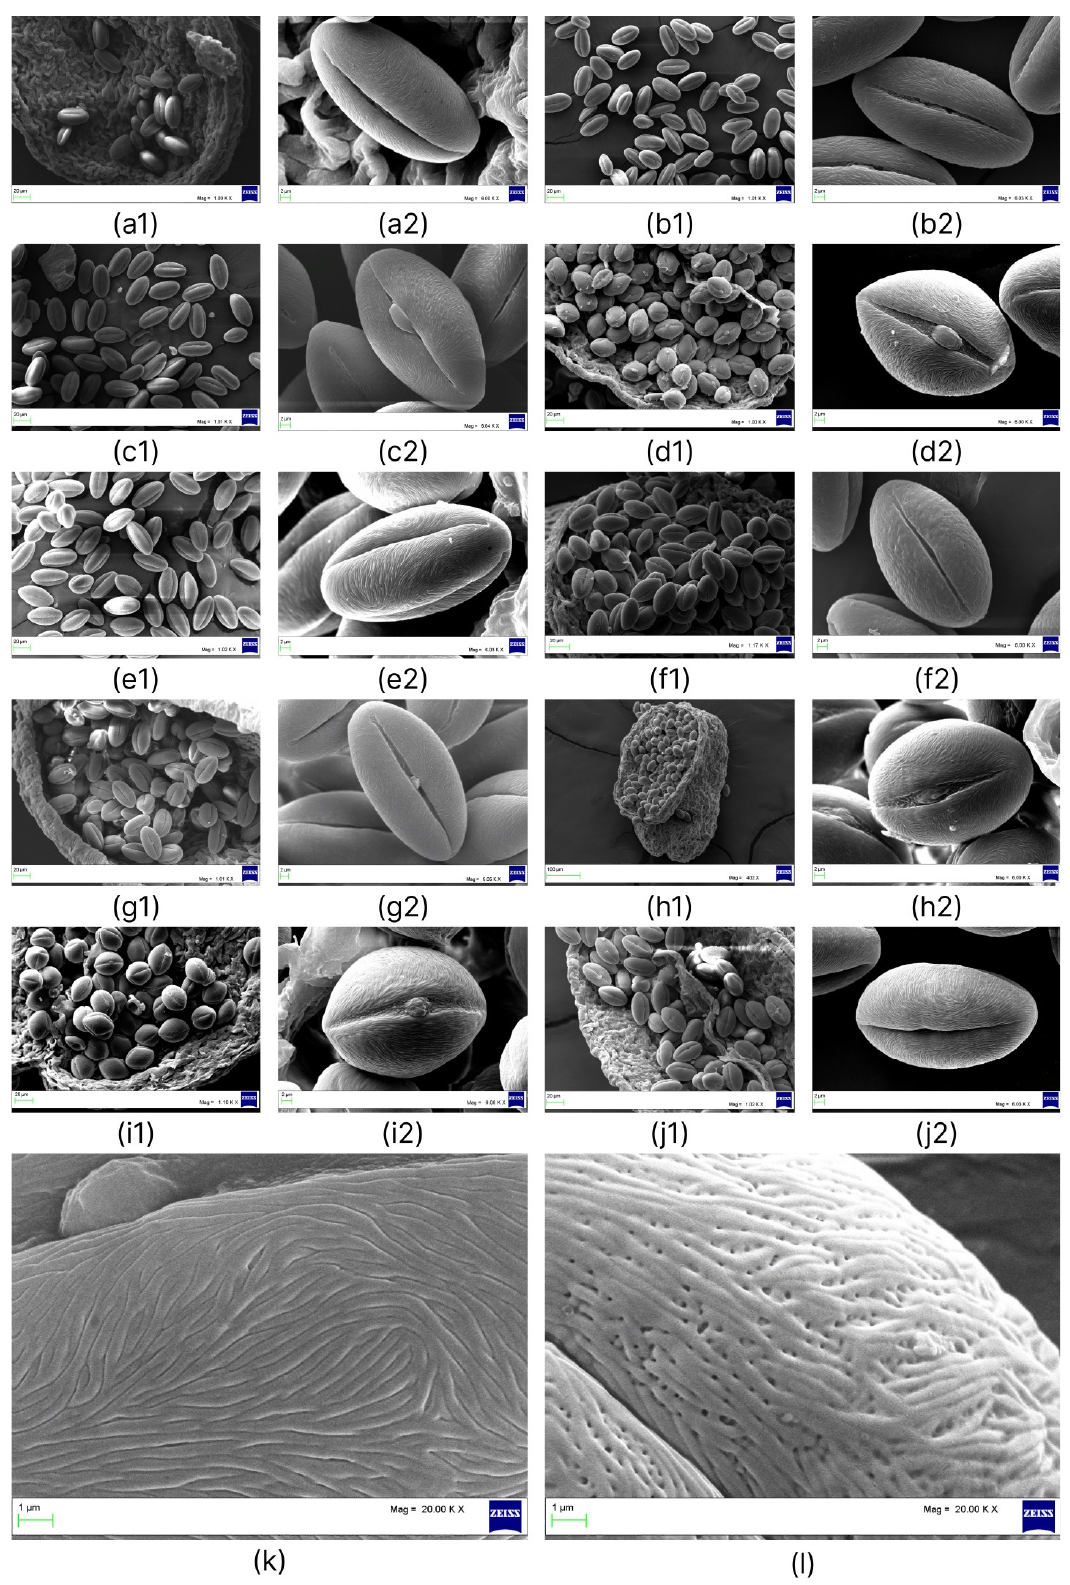
Figure 3. SEM micrographs of N. sibirica pollen. Collection sites of the photographed speci- mens: ( a1 , a2 ) Dauria; ( b1 , b2 ) Shelek; ( c1 , c2 ) Balansor; ( d1 , d2 ) Karatal; ( e1 , e2 ) Balhash ( f1 , f2 ) Kurti; ( g1 , g2 ) Kosh-Agach; ( h1 , h2 ) Taskarasu; ( i1 , i2 ) Basshi; ( j1 , j2 ) Koktal; ( k ) Kosh-Agach, details of the exine surface; and ( l ) Basshi, details of the exine